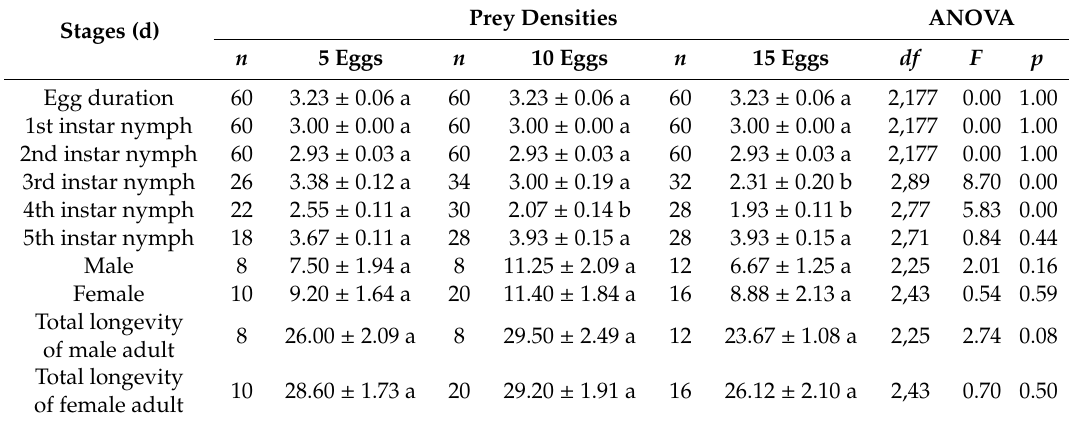
Table 2. E ff ect of three prey densities on the development time of O. strigicollis feeding on P. gossypiella eggs (prey).